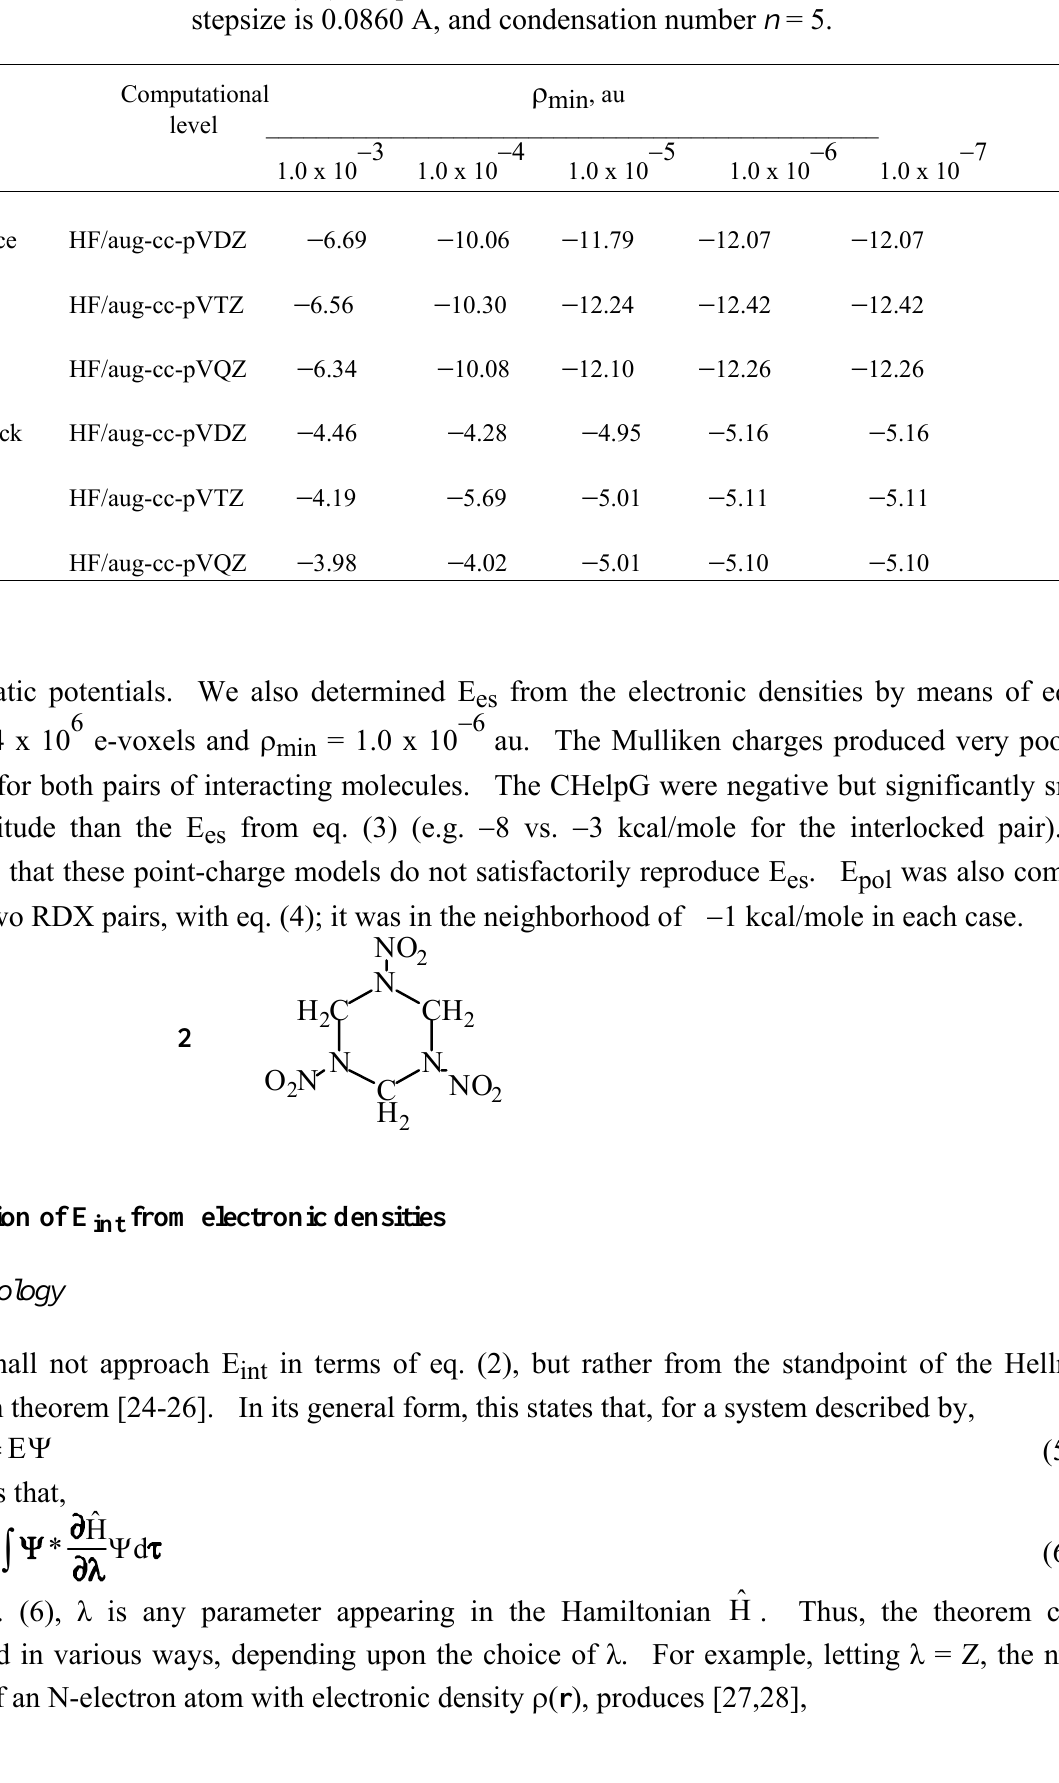
a Number of e-voxels is 1.0 x 10